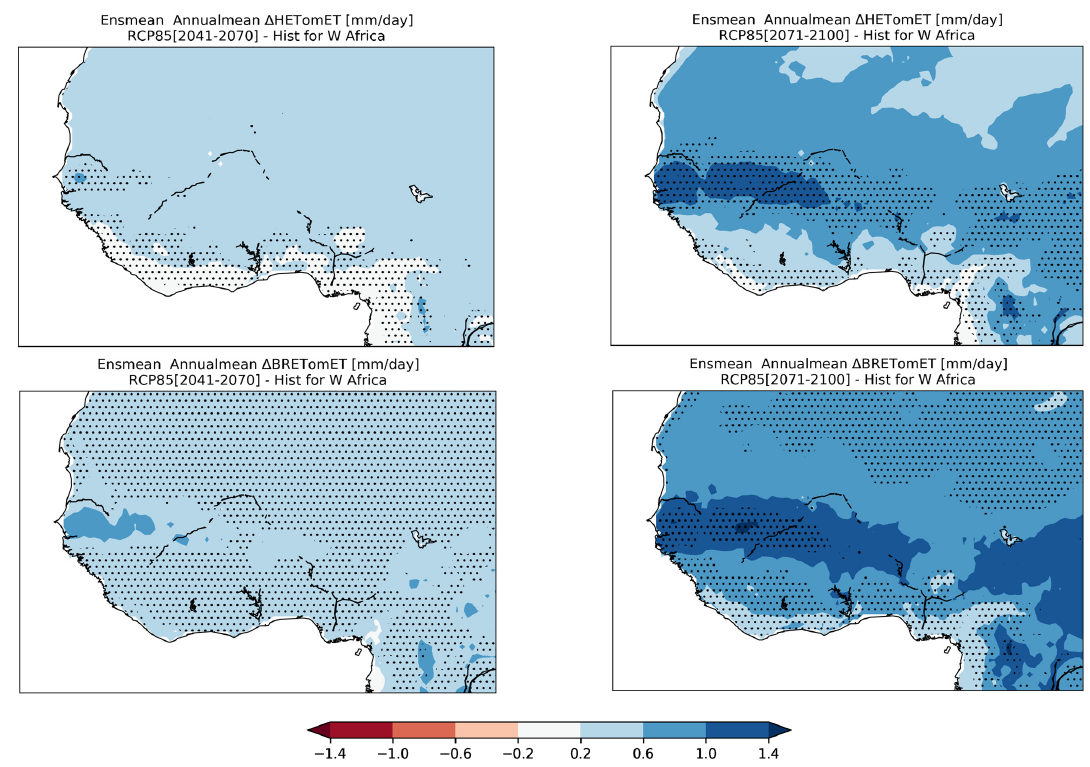
Figure 4. Projected changes in irrigation requirement (mm/day) computed using HETo ( top row) and BRETo ( bottom row) methods for mid-future ( left column) and far future ( right column) from the ensemble mean of regional climate models derived under RCP 8.5.